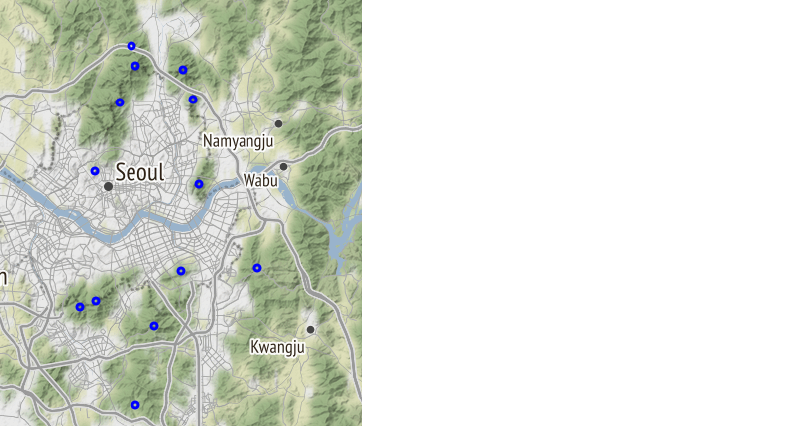
Figure 1. The cities in Metropolitan Area (black circles) and the study sites (blue circles).